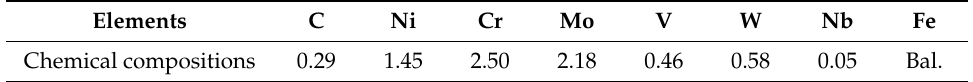
Figure 1. Thermodynamic calculation results for 25Cr3Mo3NiNb. Table 2. 25Cr3Mo2NiWVNb steel composition (mass fraction, %).